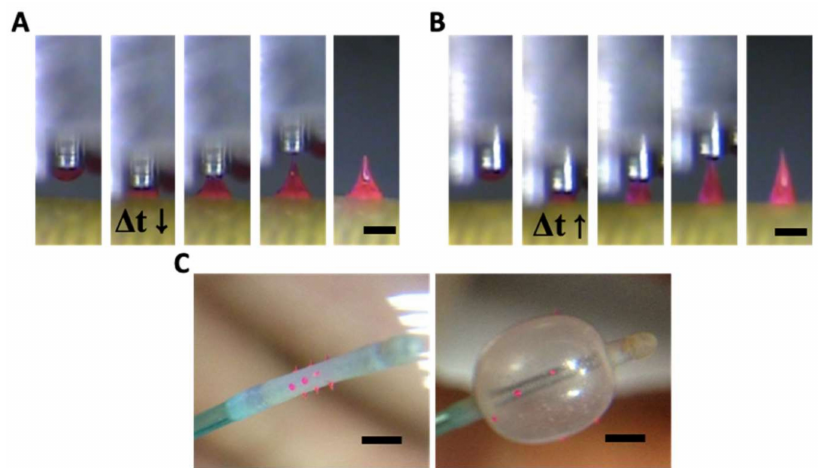
Figure 5. ( A ) Bullet and ( B ) normal shape of poly(lactic-co-glycolic)acid 90:10 microneedle (MN) formed by transfer thermal drawing onto the surface of the medical balloon ( ∆ t indicates dwell time). ( C ) Images before and after MN medical balloon inflated (scale bar = (A,B) 300 µ m, (C) 1 mm).